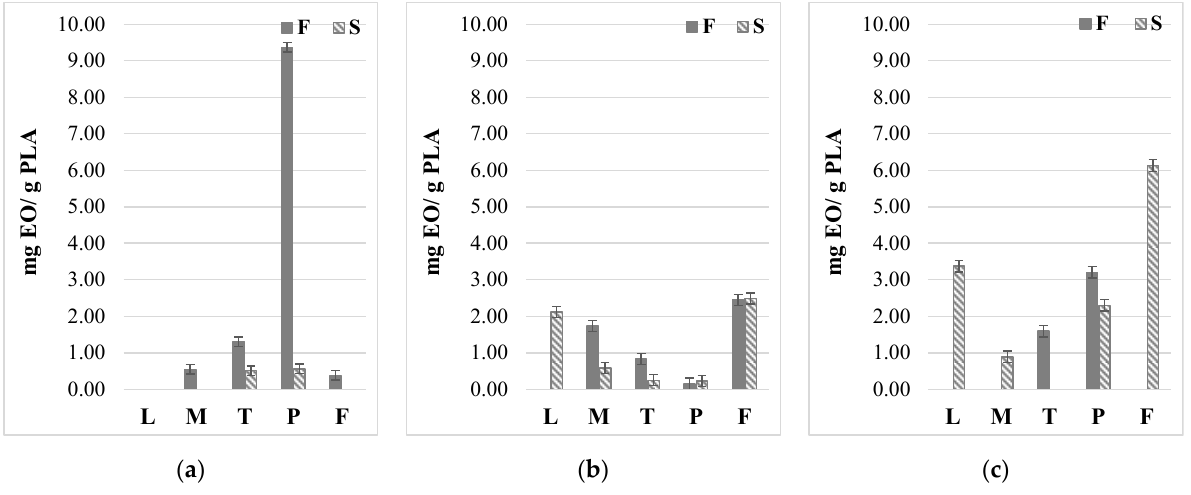
Figure 5. The specific amount of essential oil in methanol solutions at different concentrations: ( a ) 1 wt.% solution; ( b ) 1.5 wt.% solutions; ( c ) 2 wt.% solutions.